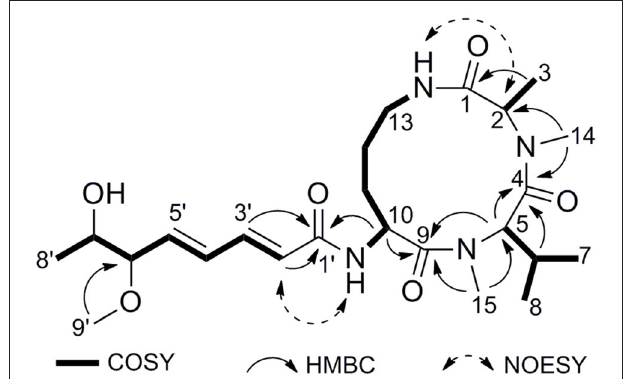
FIGURE 4 | Key COSY, HMBC, and NOESY correlations of 2 .